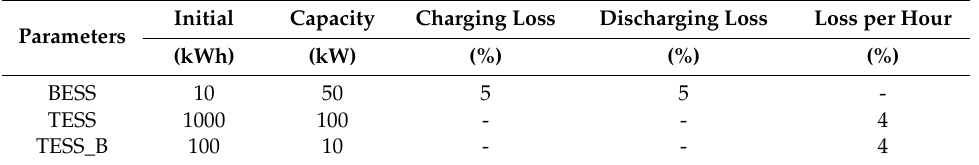
Table 2. Battery energy storage system (BESS) and thermal energy storage system (TESS) parameters.